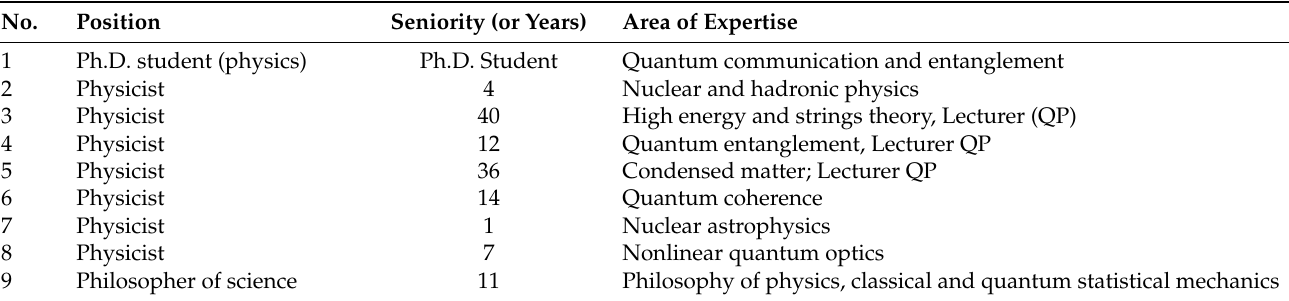
Table 1. The interviewees and their domains of